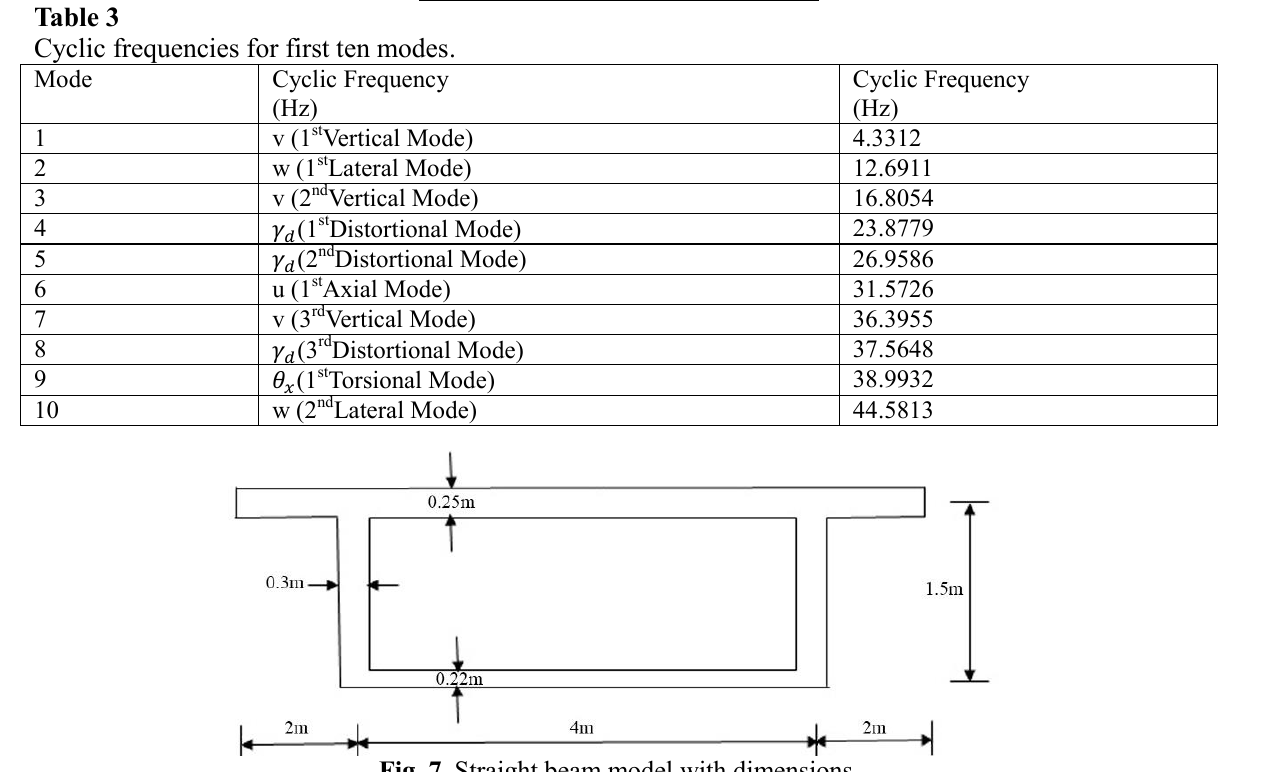
Fig. 7. Straight beam model with